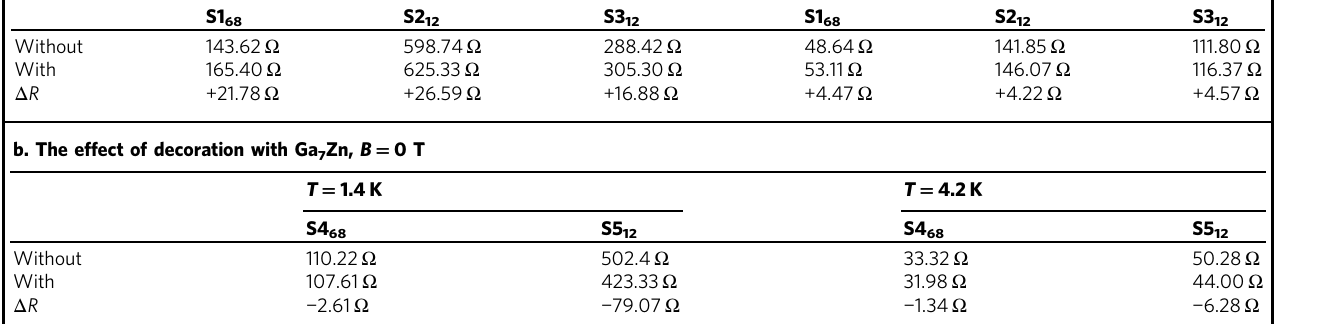
Table 1 Absolute changes of zero-magnetic- fi eld resistances caused by surface decoration a. The effect of decoration with Cr 7 Zn, B = 0 T T = 1.4